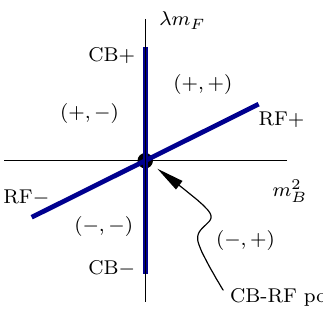
Figure 30. The features of the CB-RF theory in the neighbourhood of the CB-RF conformal point depicted as a thick dot at the origin. The blue lines correspond to the various quasi-fermionic conformal theories that emanate / terminate at the origin. The various topological phases are also shown. The (cid:12)gure is plotted for x 4 >